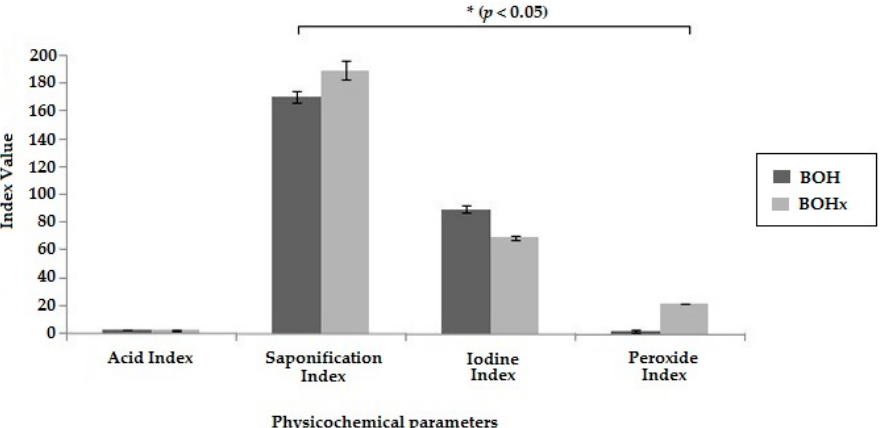
Figure 1. Physicochemical parameters resulting from the analysis of bullfrog oil. Acid index (mg of KOH/g of oil); Saponification index (mg of KOH/g of oil), Iodine index (g of iodine absorbed/100 g of oil), and Peroxide index (mEq of active oxygen/1000 g of oil). Dark gray: bullfrog oil extracted by heating process (BOH); Light gray: bullfrog oil extracted by the organic solvent process (BOHx). * Statistical Difference.